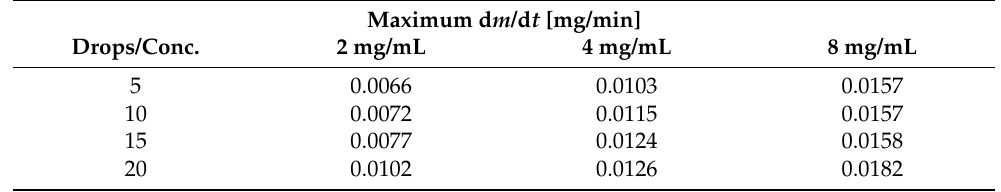
Table 1. Maximum absolute MX release rate achieved from planar